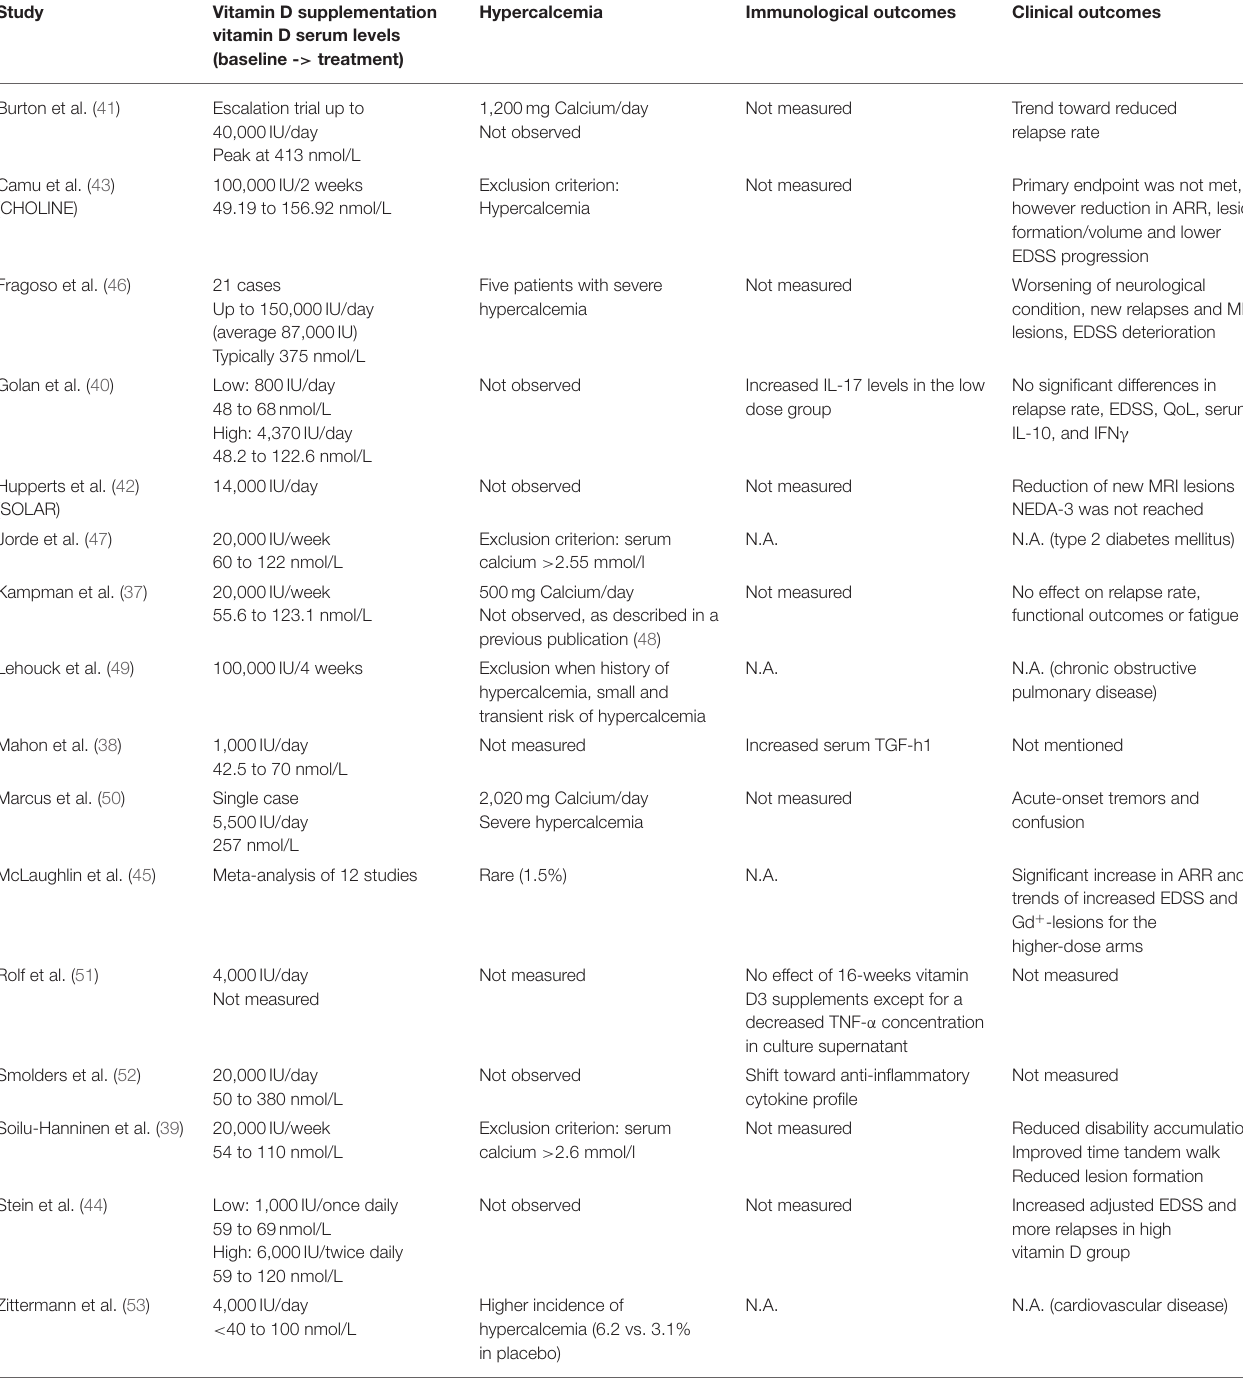
TABLE 1 | Overview of relevant vitamin D supplementation